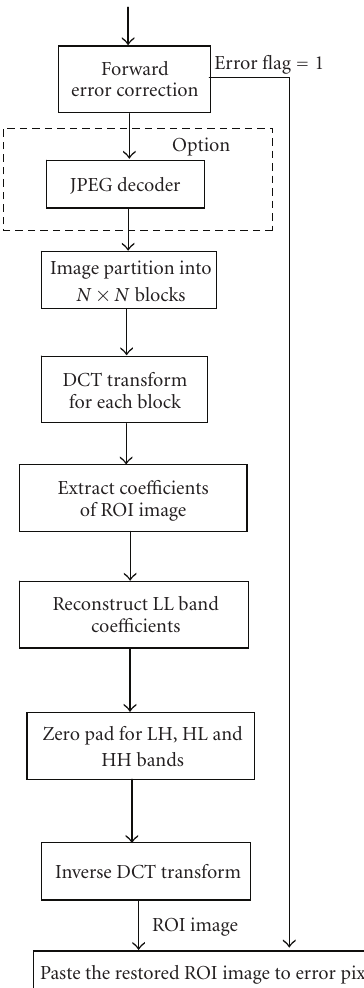
Figure 4: The decoding flow for ROI image